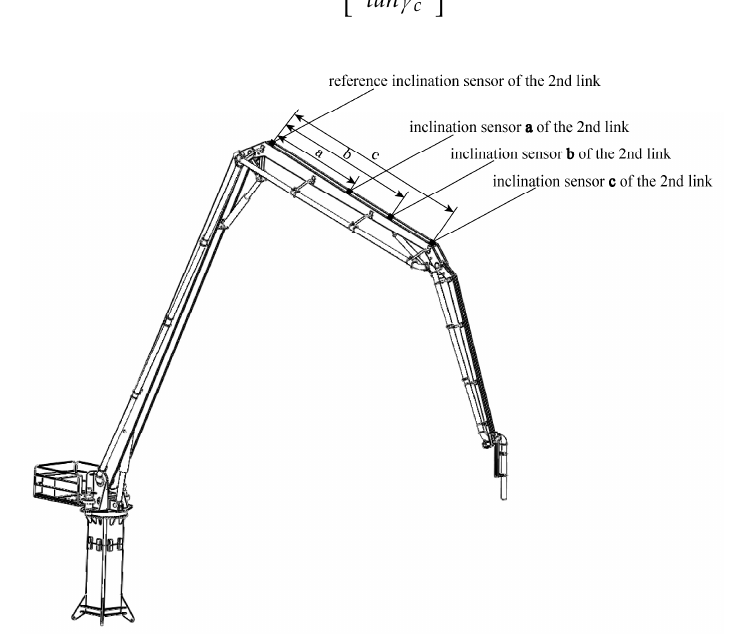
Figure 4. Schematic diagram of installation positions of inclination sensors.